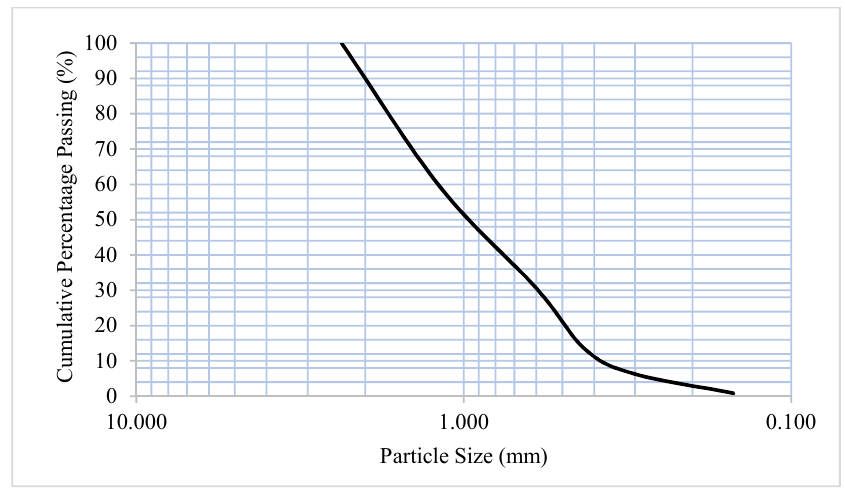
Figure 1. Particle size distribution of fine aggregate.